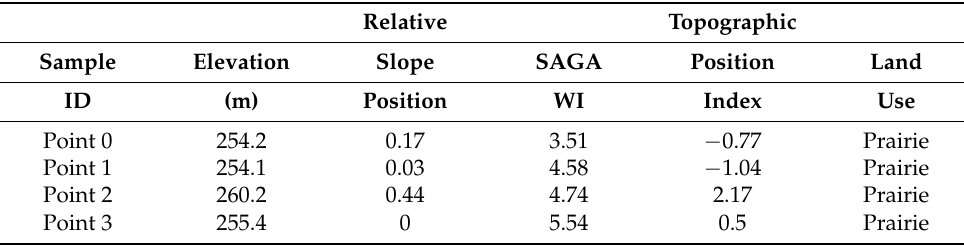
Figure 2. Elevation and terrain attributes of the study site derived from a digital elevation model (DEM) generated for locating sampling sites based on Latin hypercube conditions. Numbers represent the Sample ID (see Table 1). Table 1. Terrain attributes and land use types by soil sampling points. Note that NA stands for not